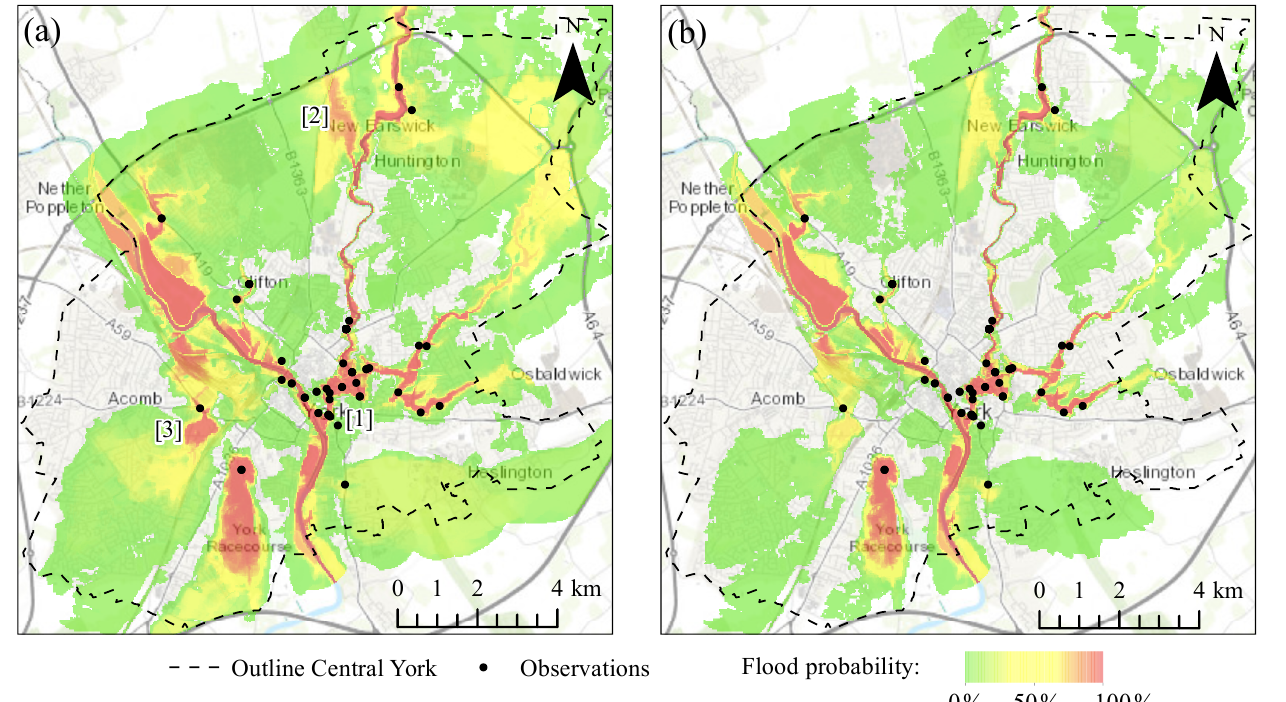
Figure 7. Probabilistic flood map generated by simulating locational errors, errors in elevation data and errors in parameters (a) and a probabilistic map generated simulating errors in the elevation data and parameters only (b) . The locations denoted by the numbers [1] to [3] are referred to in text.